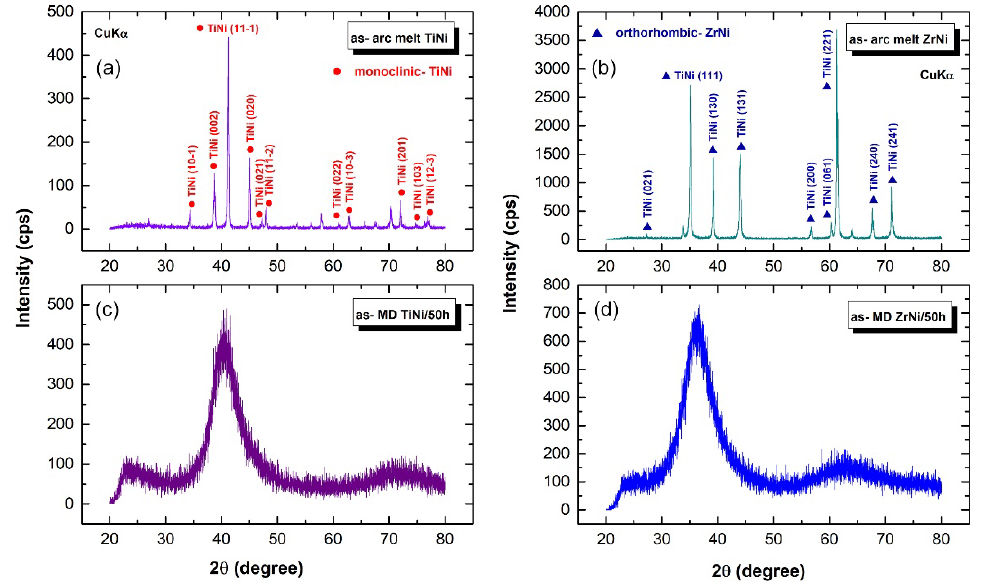
Figure 5. X-ray diffraction (XRD) patterns of as-arc-melt ( a ) Ni 50 Ti 50 and ( b ) Ni 50 Zr 50 . The XRD patterns of as-mechanically disordered (MD) powders obtained after high-energy ball milling for 50 h of the Ni 50 Ti 50 and Ni 50 Zr 50 systems are displayed, respectively, in ( c ) and ( d ).